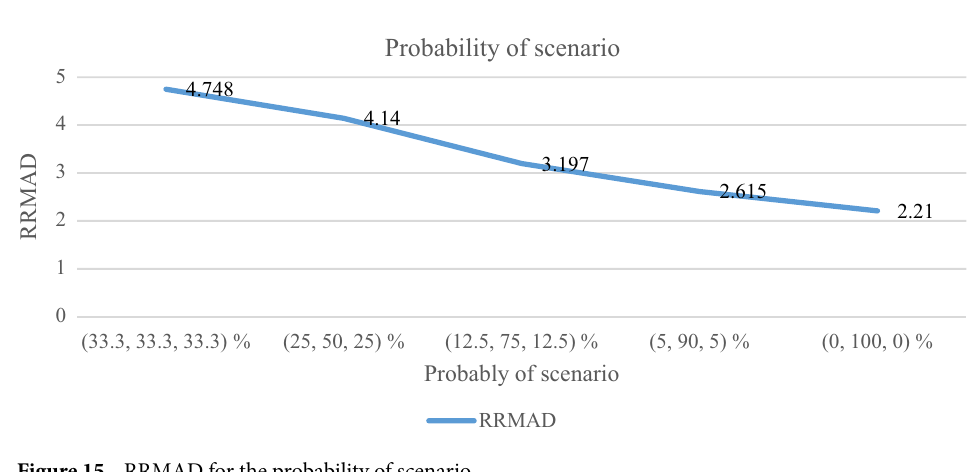
Figure 15. RRMAD for the probability of